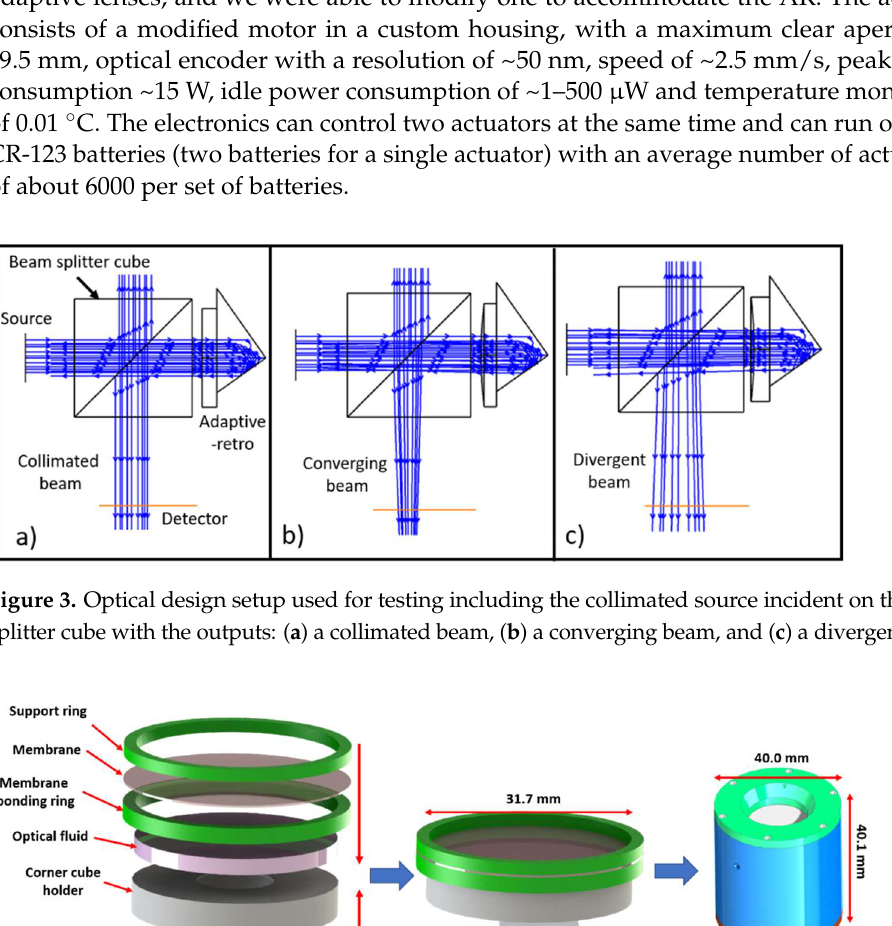
Figure 3 . Optical design setup used for testing including the collimated source incident on the beam splitter cube with the outputs: ( a ) a collimated beam, ( b ) a converging beam, and ( c ) a divergent beam.